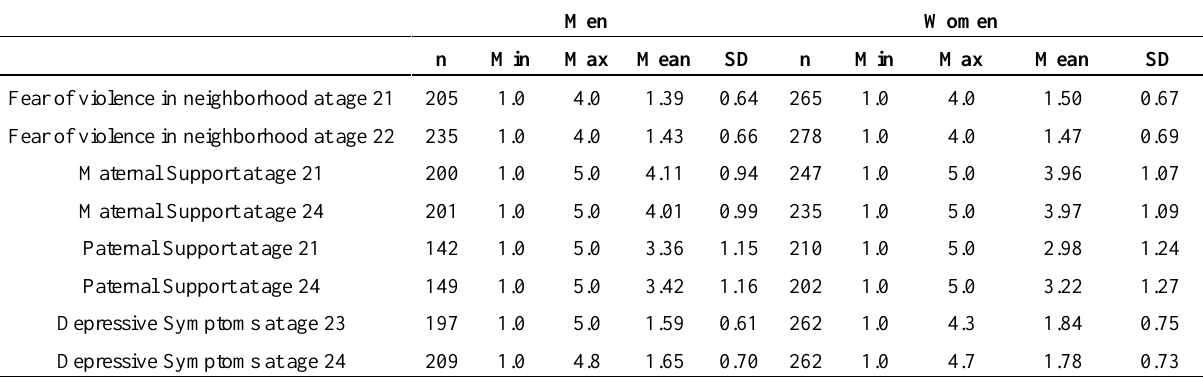
Table 1. Descriptive statistics among male and female African American youth.